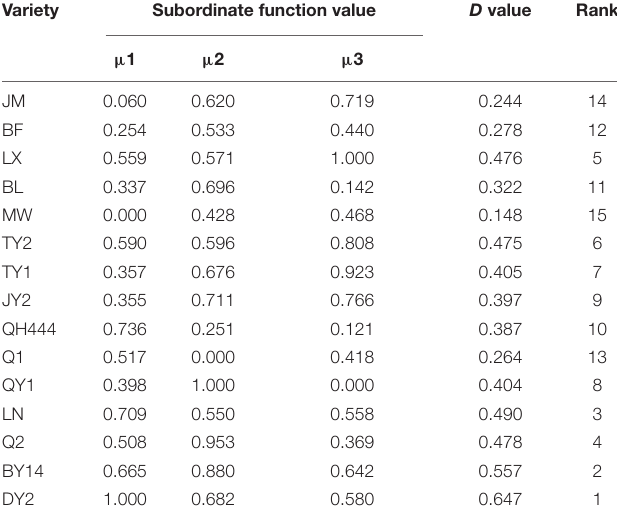
TABLE 4 | Subordinate function and D value of the drought resistance